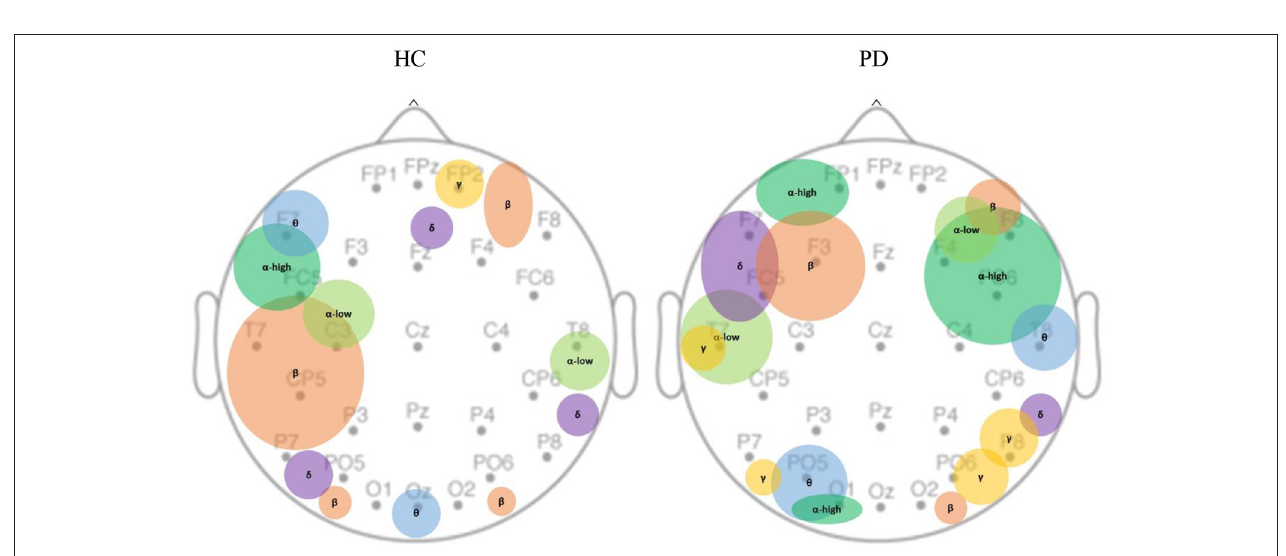
FIGURE 4 | Average Beta values of BB model (Characterizing EEG bands contribution). In the healthy control group, the delta band always negatively correlated with MV, and theta, alpha-low, and beta correlated positively. In the PD population, gamma and beta always negatively correlated with MV, and theta correlated positively. PD, Parkinson’s disease; HC, healthy controls. Sham: No stimulation, GVS1: 50–100Hz; GVS2: 100–150Hz.